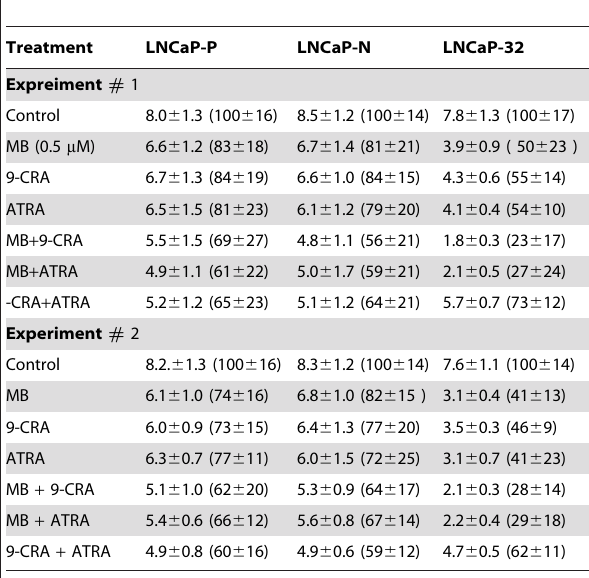
LNCaP-P, LNCaP-N and LNCaP-32 cells were seeded in 6-cm dishes in replicate (5 6 10 4 cells/dish) and treated with 9-CRA (0.5 m M), ATRA (0.5 m M), and MB (1 nM) either alone or in combination. Cells were grown for 11 days with a medium change at day 4 and 7. Cell growth was determined as in Table 3. The values represent Mean number of cells per dish 6 10 5 6 SE of the Mean. Values in the parentheses represent Means of % Growth 6 SE of the Mean.